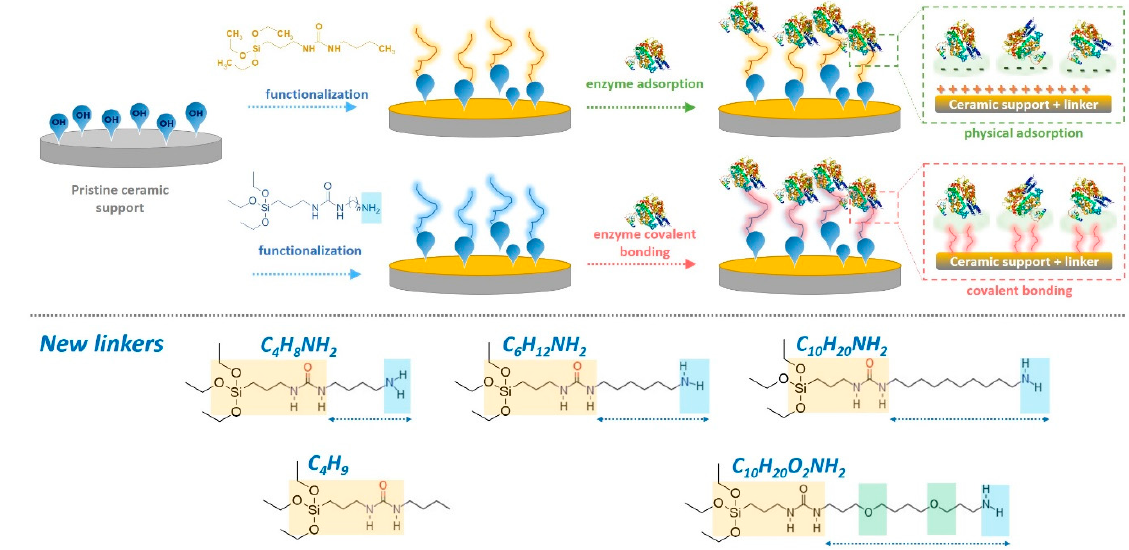
Figure 1. Scheme of the ZrO 2 ceramic membrane functionalization by different modifiers and enzyme modifications (upper part) via physically adsorbed enzyme and covalently bound enzyme. Presentation of newly synthesized linkers (lower part).